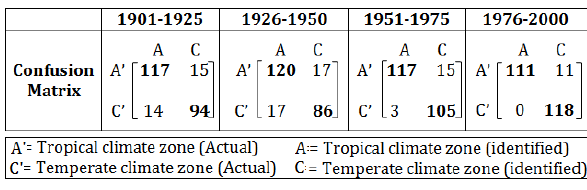
Figure 9. Confusion matrices obtained in climate zone identifica- tion